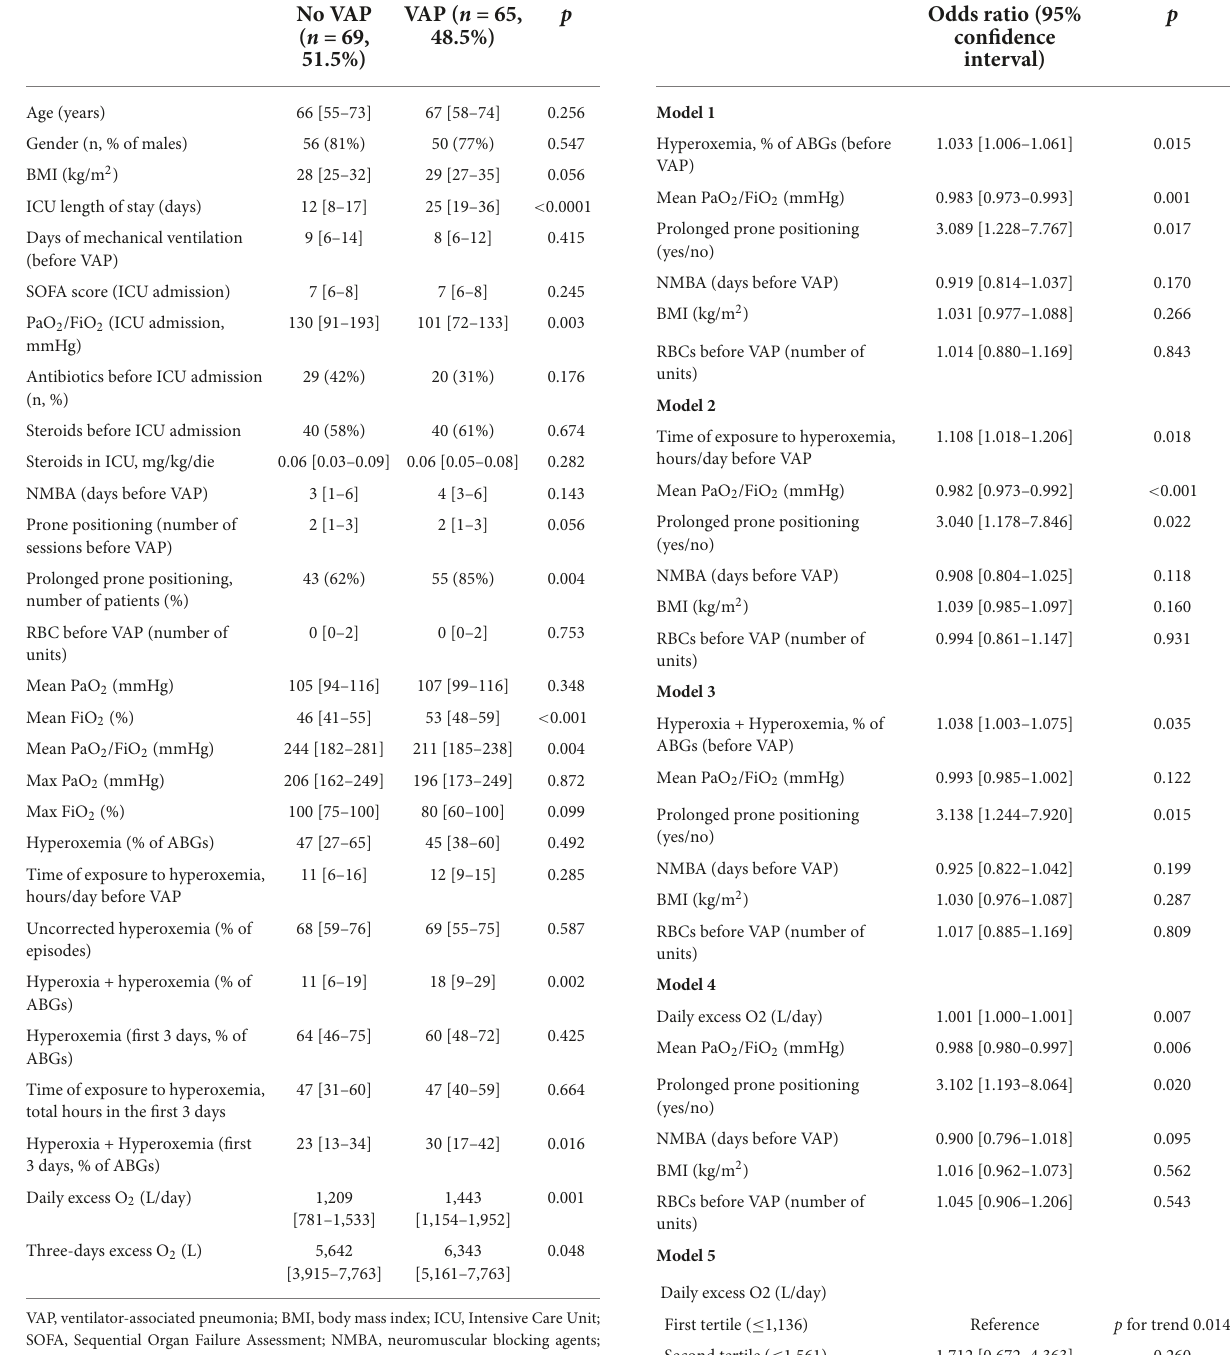
TABLE 5 Comparison between patients whit at least one episode of VAP and those without any episode of VAP.